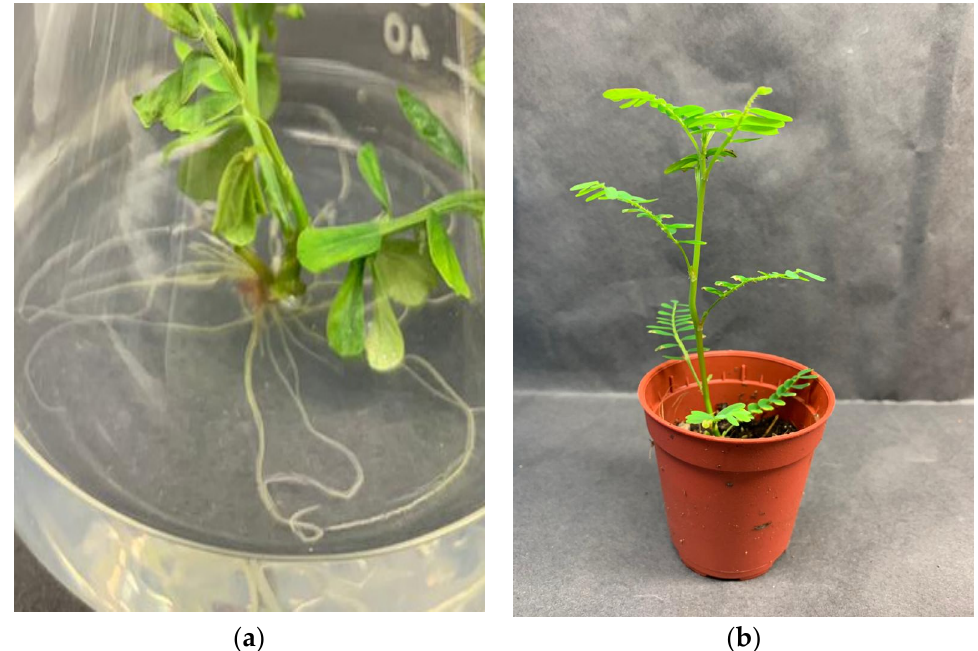
Figure 2. ( a ) Root development of P. niruri in media containing 2.5 µM IBA on week 4 after inocu- lation; ( b ) Survived P. niruri planlet in mixture of coco peat + peat moss (1:1) treatment on week 4 of acclimatization.